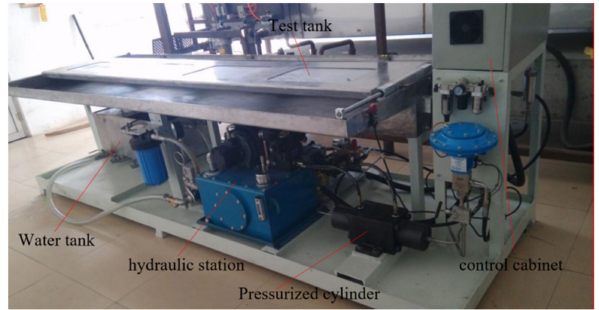
Figure 15. Experimental platform